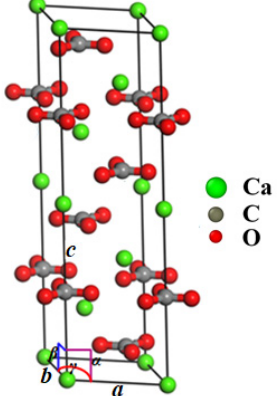
Figure 1. Calcite unit cell (green for Ca, gray for C, and red for O).